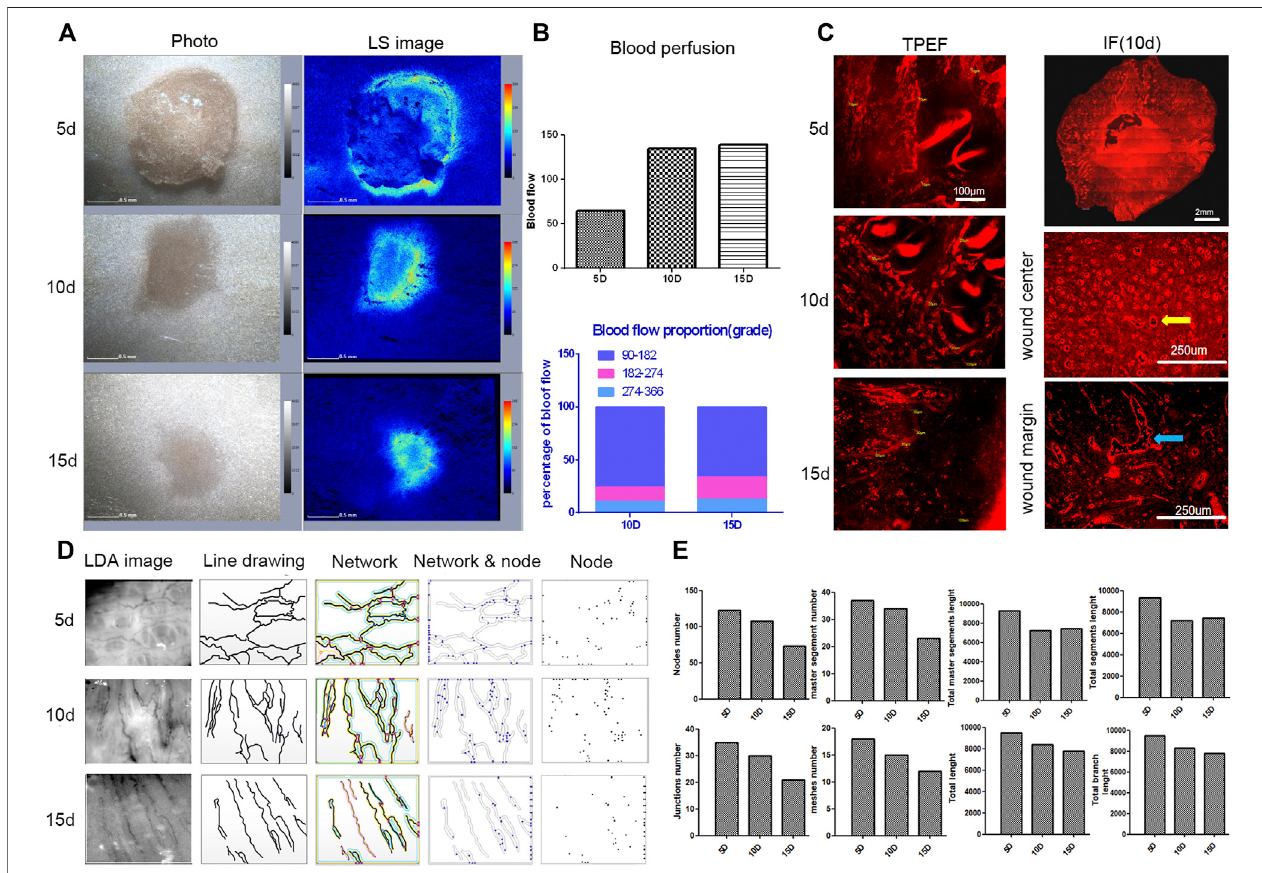
FIGURE 8 | Analysis of blood perfusion and vascular morphology during wound healing. (A) LSCI images of wound healing. (B) TPEF images of blood vessels during wound healing. (C) IF staining in horizontal sections of the wound (the panoramic image of the wound and enlarged images of the center of the wound and the woundedgeandverticalvesselsaremarkedwithyellowarrows). (D) OriginalandprocessedimagesoftheLDAinthewoundedges(includinglinedrawings,bloodvessel network, network and nodes, and nodes). (E) Diagrams of capillary statistics (including node numbers, junction numbers, meshed numbers, master segment numbers, total length, total master segment length, total branch length, and total segment